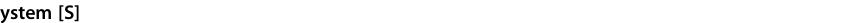
Table 2 New anticipatory governance framework with criteria